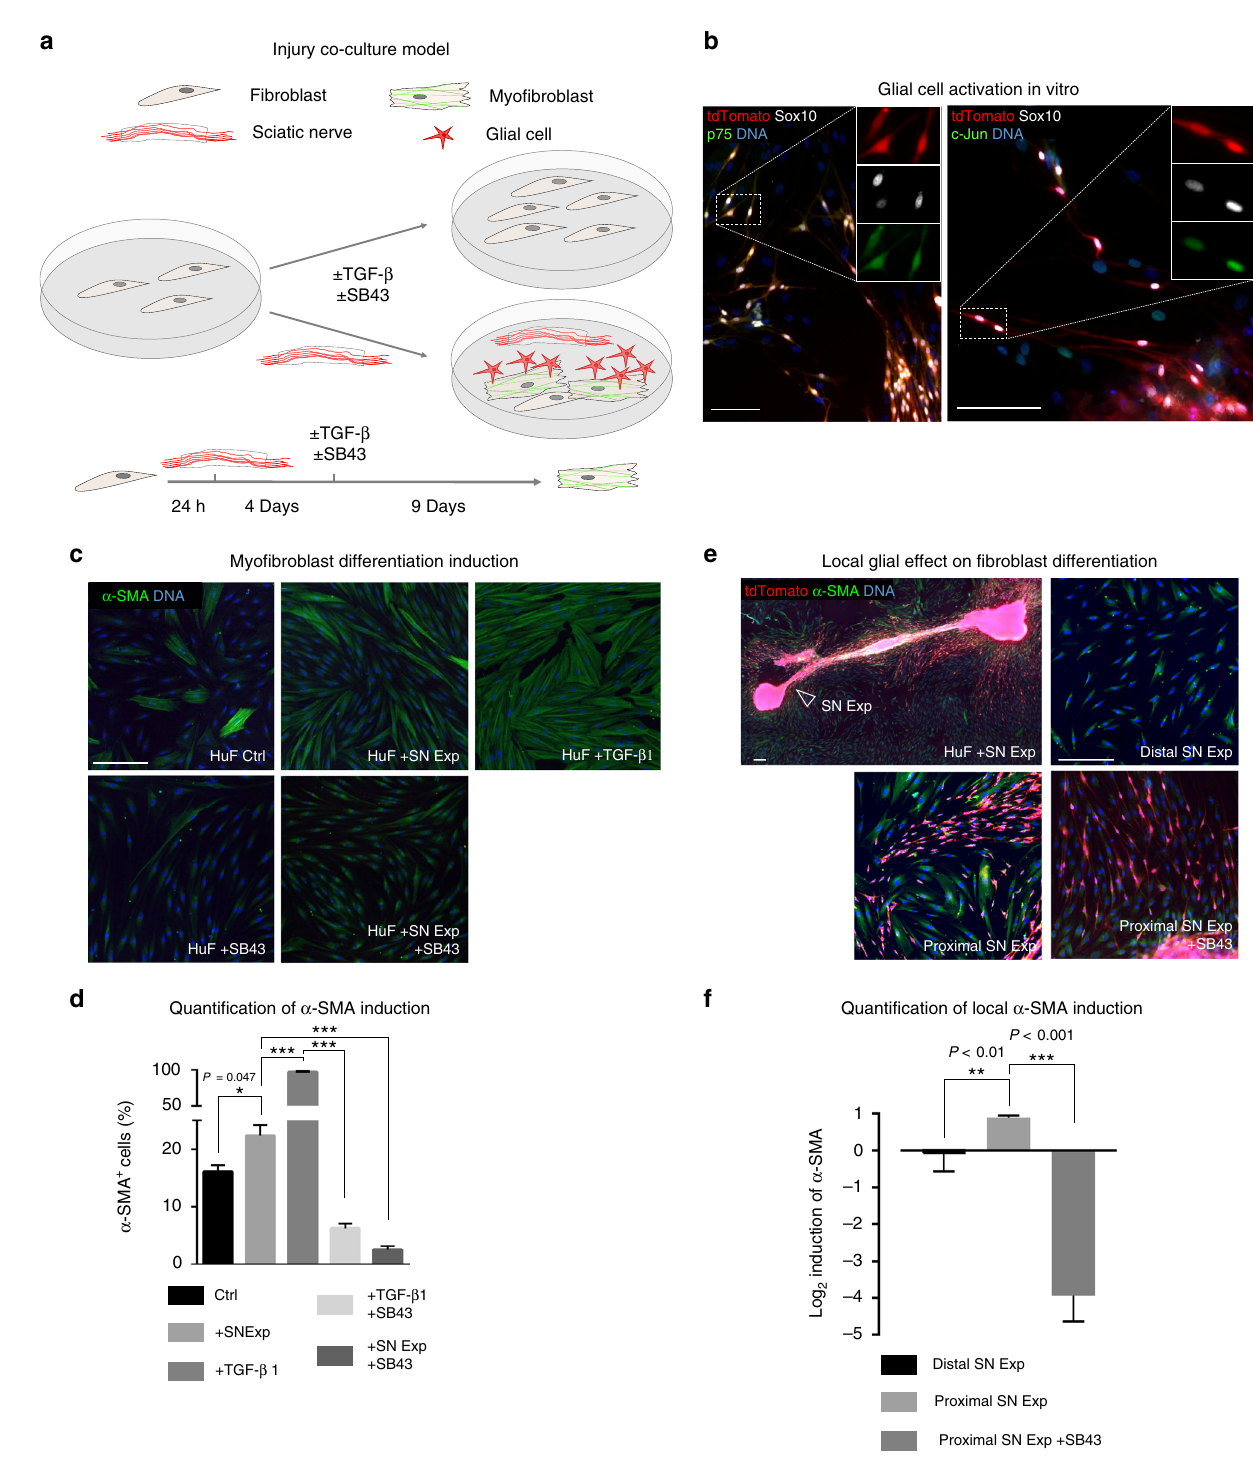
Fig. 7 Activated glia from SN Exps promote myo fi broblast differentiation in a TGF- β signalling-dependent manner. a Experimental scheme of HuF cultured in the presence of murine Dhh-Cre; tdTomato SN Exp with optional pharmacological modulation of TGF- β signalling pathway. b Immuno fl uorescence of SN Exp show tdTomato-traced cells (red) expressing markers of activated glia, such as Sox10 (white), p75 (green), and c-Jun (green). Note that similar results were obtained even in the absence of fi broblasts. c Immunolabelling of α -SMA + (green) HuF upon SN Exp co-culture, TGF- β 1 treatment or SB43-mediated TGF- β signalling blockade and d respective quanti fi cation of α -SMA induction for each culture condition. *** P < 0.001 compared to Ctrl. e Immunolabelling of local α -SMA + induction in tdTomato − HuF in the direct vicinity of the SN Exp compared to areas distant from the SN Exp (one fi eld of view from nearest tdTomato + cell using 10× objective) of the same well in combination with SB43-mediated TGF- β signalling blockade. f Respective quanti fi cation of local α - SMA induction for each culture condition. Data are represented as mean ± SEM. Scale bars, 100 µ m ( b ), 300 µ m ( c , e